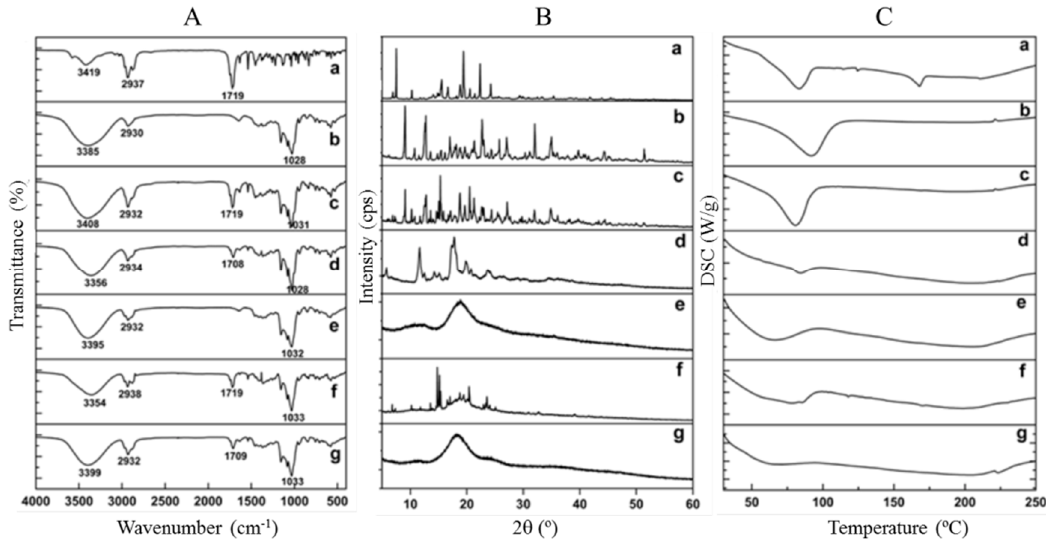
Figure 4. ( A ) FT-IR spectra, ( B ) PXRD patterns and ( C ) DSC curves of (a) RBG, (b) β -CD, (c) RBG/ β -CD PM (1:2 molar ratio), (d) RBG/ β -CD complex, (e) HP- β -CD, (f) RBG/HP- β -CD PM (1:2 molar ratio), and (g) RBG/HP- β -CD complex.